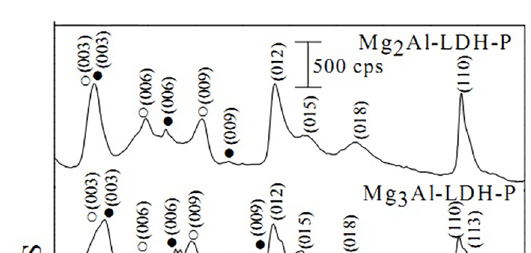
Figure 1. Diffractograms of pristine LDHs: Mg LDH, Mg